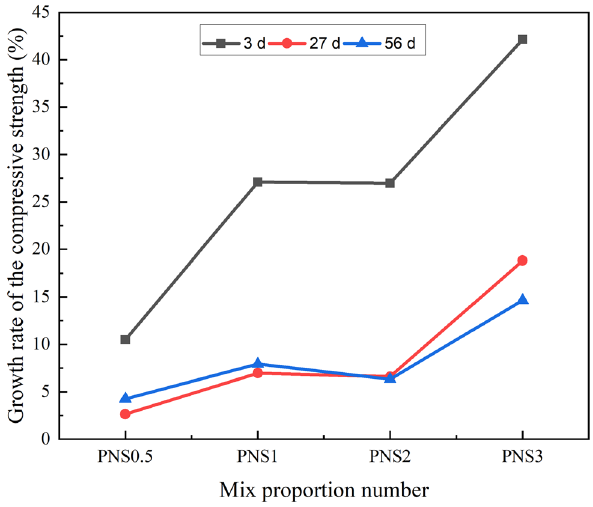
Figure 3: The growth rate of the compressive strength [ 79 ]